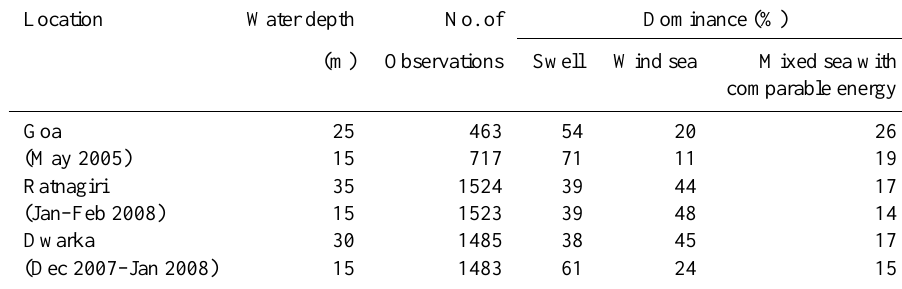
Table 2. Percentage of swell, wind sea and mixed sea with comparable energy during non-monsoon season. Location Water depth No. of (m) Observations Swell Wind sea Mixed sea